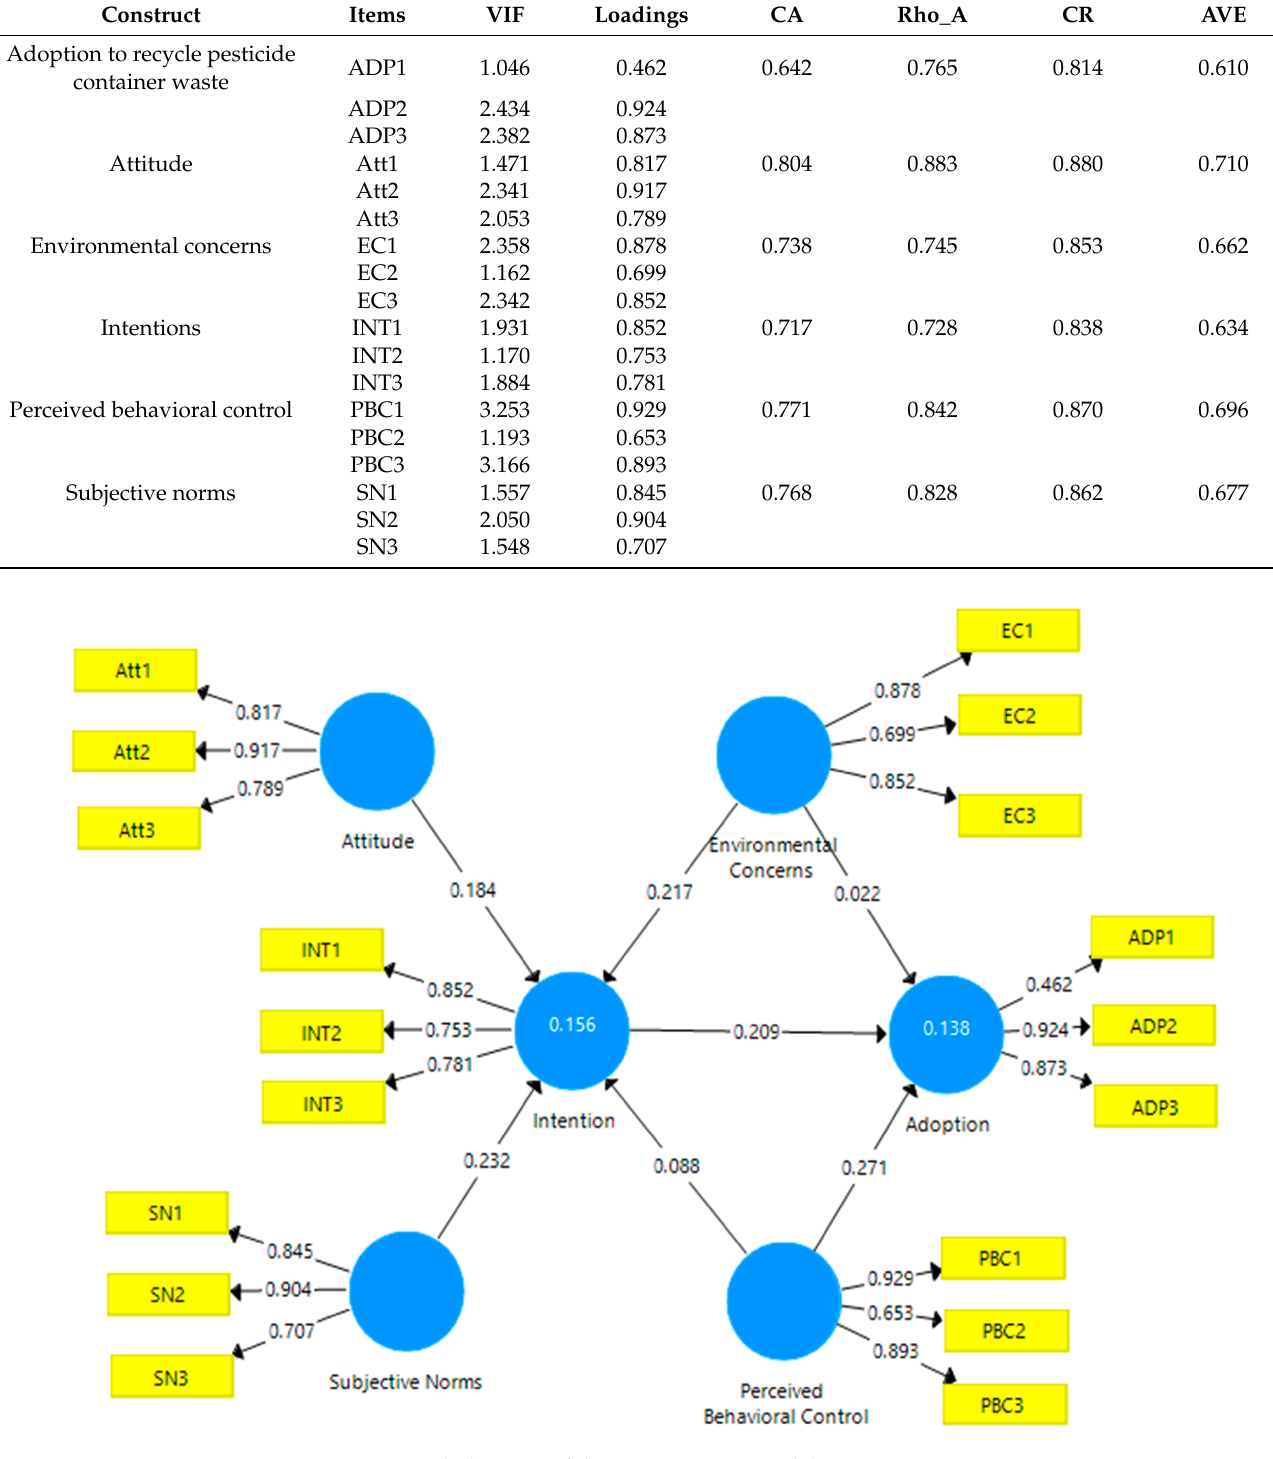
Figure 2. Path diagram of the measurement model. Figure 2 (path diagram of the measurement model) explains three measurements; the inner model shows the values of path coefficients, the outer model shows the model’s outer loadings, and the R-square values are presented in the circles. In addition, we tested the discriminant validity using the Fornell-Larcker and Heterotrait-Monotrait ratio of correlations (HTMT) criteria [59]. According to the Fornell-Larcker criteria, all